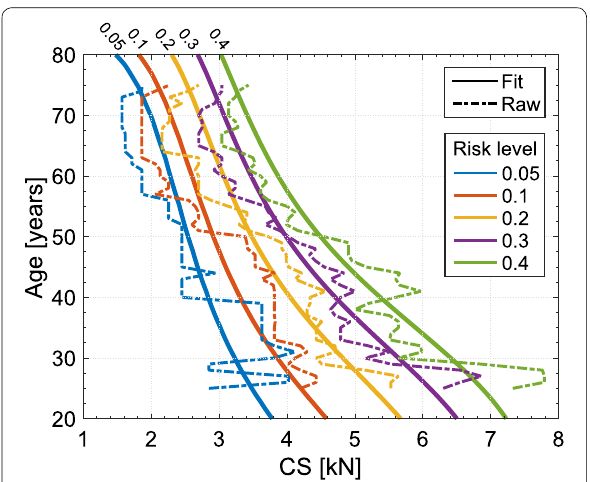
Fig. 10 Contour graph of the low‑risk‑level weighted risk curves for specific ages. CS, compressive